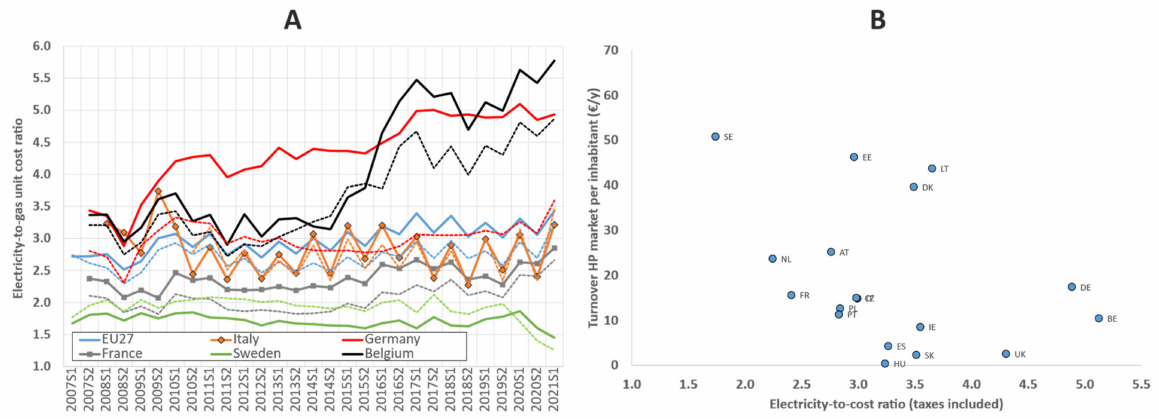
Figure 6. ( A ) The trend of the electricity-to-gas cost ratio in the European Union (EU27), Italy, Germany, France, Sweden and Belgium between 2007 and 2021. The full-line curves refer to the cost ratio, including all taxes and levies, whereas dashed lines refer to the cost ratio without taxes. Data sources: Eurostat database [21], electricity prices for households (500 to 5000 kWh/year),